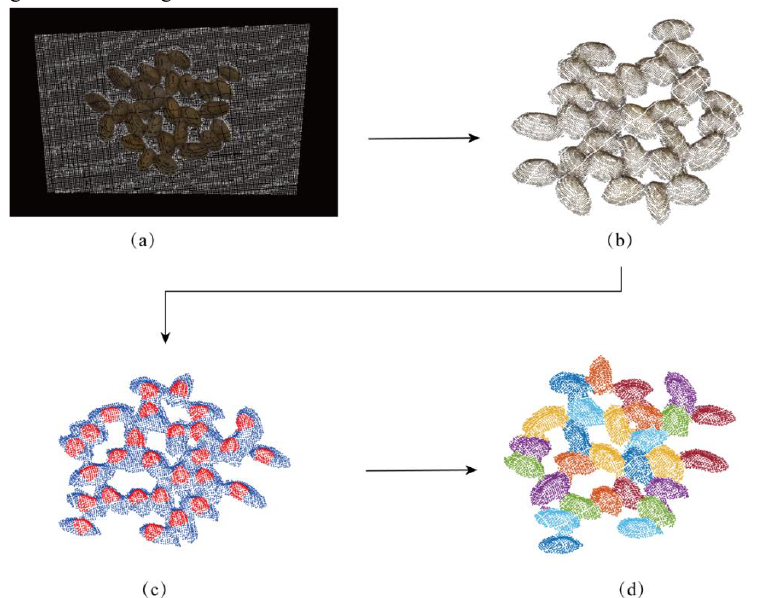
Figure 3 . Proposed single nut segmentation algorithm. (a) Raw point cloud; (b) Background point cloud removal; (c) The